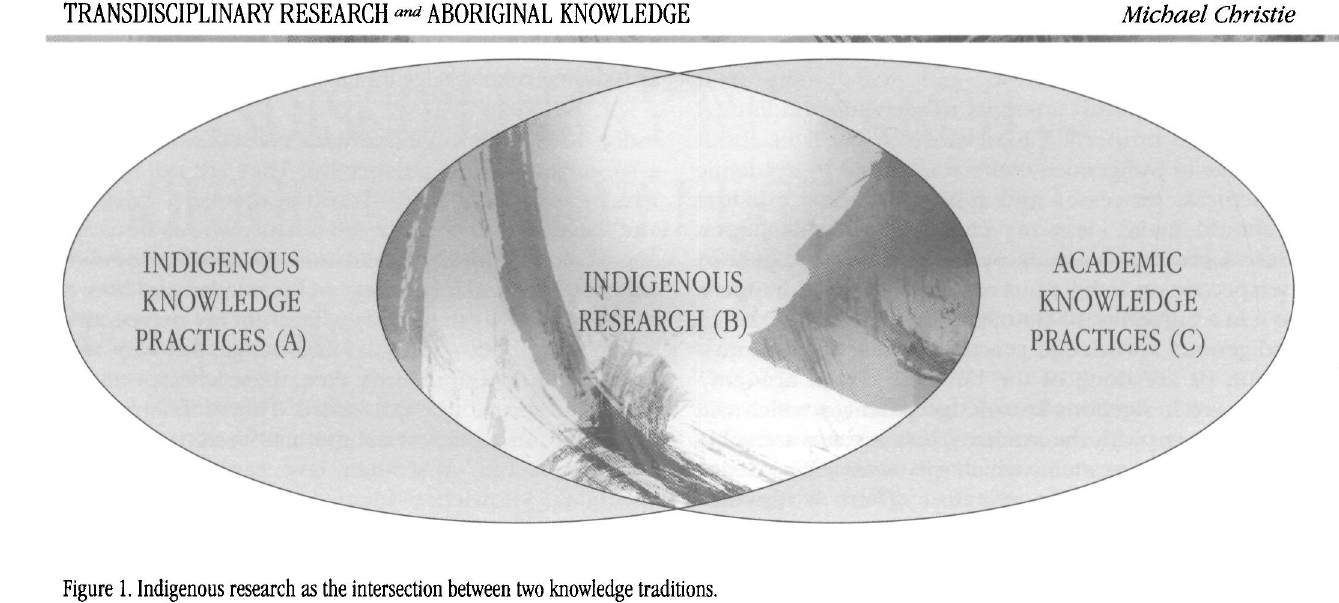
Figure 1. Indigenous research as the intersection between two knowledge